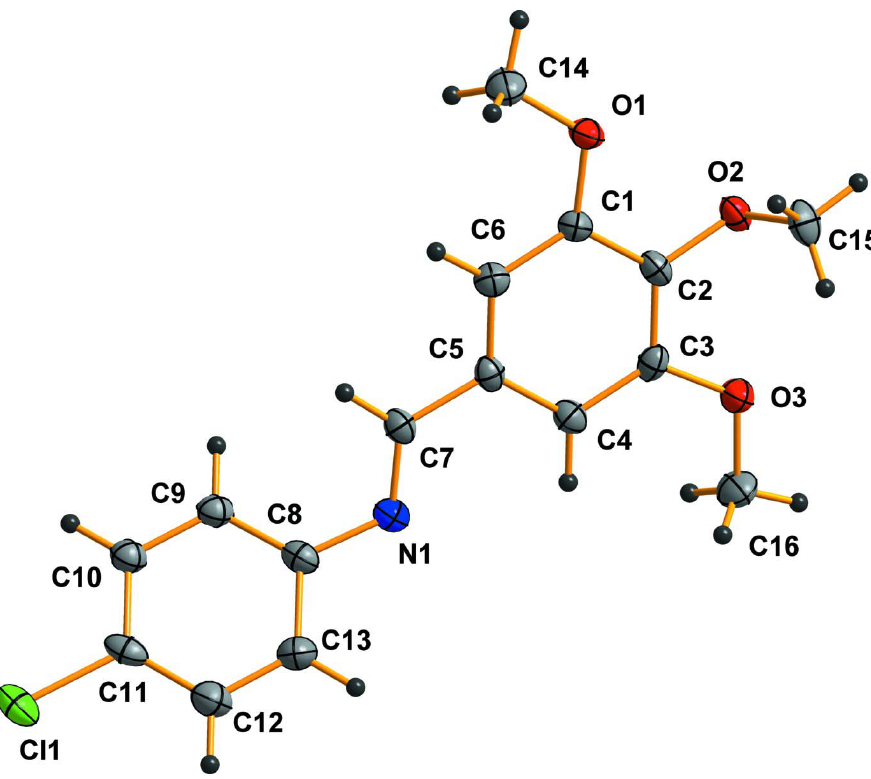
Figure 1 The molecular structure of the title compound with atom-labeling scheme. Displacement ellipsoids are drawn at the 50% probability